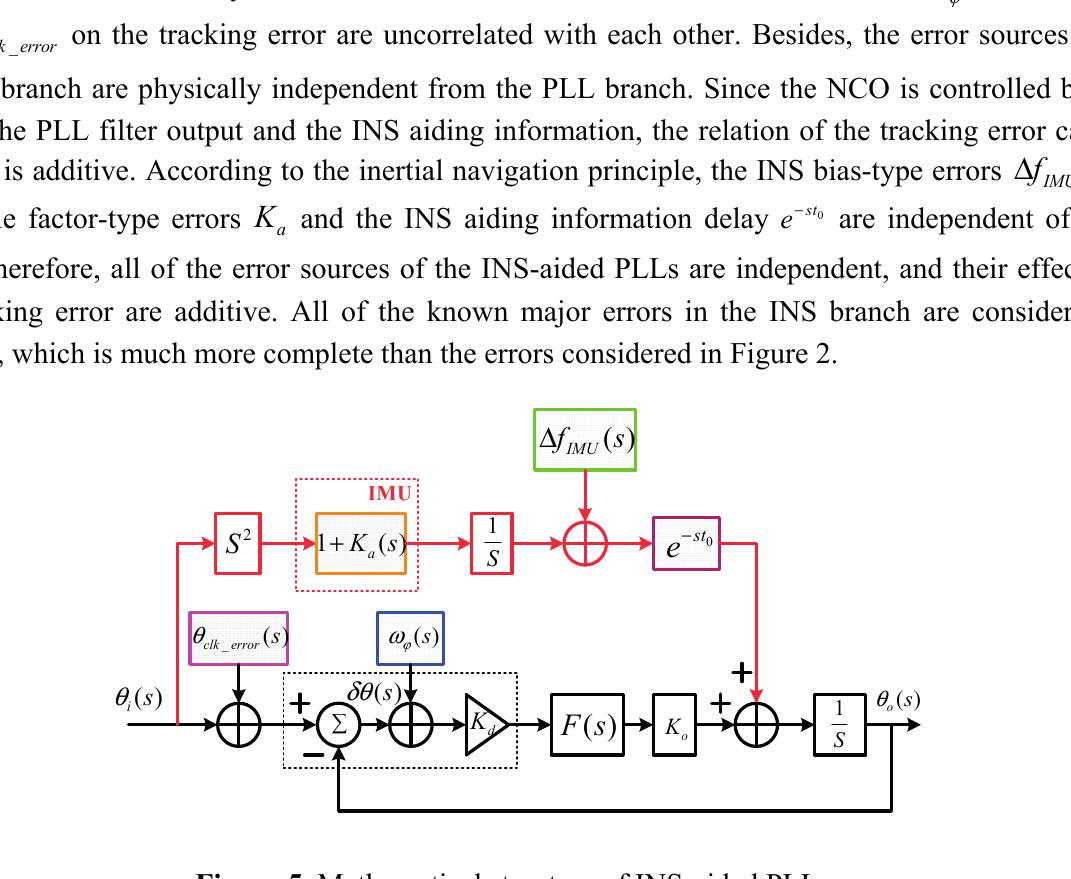
Figure 5. Mathematical structure of INS-aided